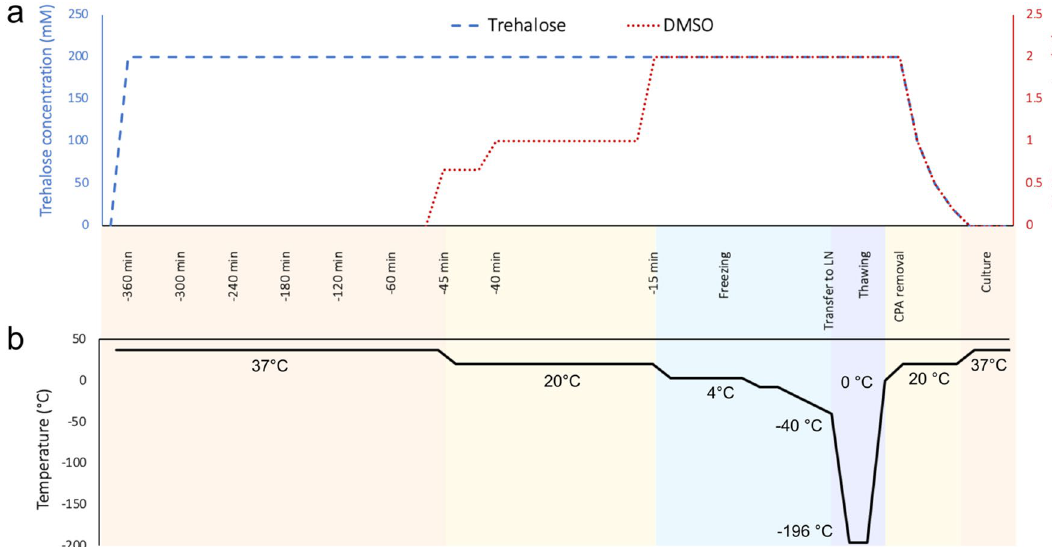
Figure 3. Schematic of the proposed islet cryopreservation protocol. ( a ) Changes in concentrations of cryoprotectants in the cryopreservation solution over time. ( b ) Changes in temperatures of the cryopreserved sample over time of the cryopreservation (time of freezing is t = 0 min). Islets are preincubated in 200 mM trehalose at 37 °C for 6 h (trehalose is kept at stable concentration throughout the incubation). 45 min before the end of this incubation time, step-wise DMSO addition protocol is initiated and samples are frozen in a programmable freezer. Frozen samples are plunged into liquid nitrogen and stored in a liquid nitrogen dewar until thawing. Thawing is performed in a 37 °C water bath until sample reaches 0 °C and CPAs are removed using a step-wise protocol. Thawed islets are transferred into a fresh culture medium and can be cultured at 37 °C. CPA cryoprotectant, LN liquid (Fig. 5b). The ATP/ADP ratios and mitochondrial DNA oxidation levels were reflected in the post-thaw viability scores in the three groups (Supplementary Fig. 4f). To examine the integrity of intracellular pathways regulating insulin secretion, we next investigated activation of adenylyl cyclase and production of cyclic AMP (cAMP) 37 in fresh and cryopreserved islets. cAMP production induced by the adenylate cyclase activator forskolin (Fig. 5c) and incretin hormone GLP-1 (Fig. 5d) was comparable in fresh, DMSO- and DT6h-cryopreserved islets, sug- gesting that this pathway remains intact after cryopreservation using both methods.